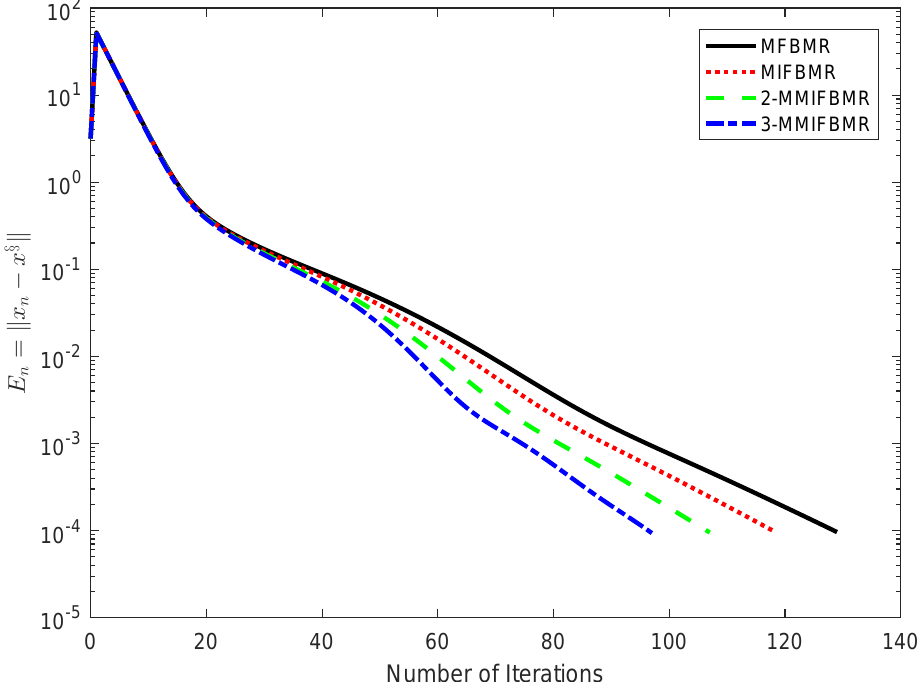
Figure 3. Comparison of MFBMR, MIFBMR, 2-MMIFBMR and 3-MMIFBMR in Example 2 with s = 10.